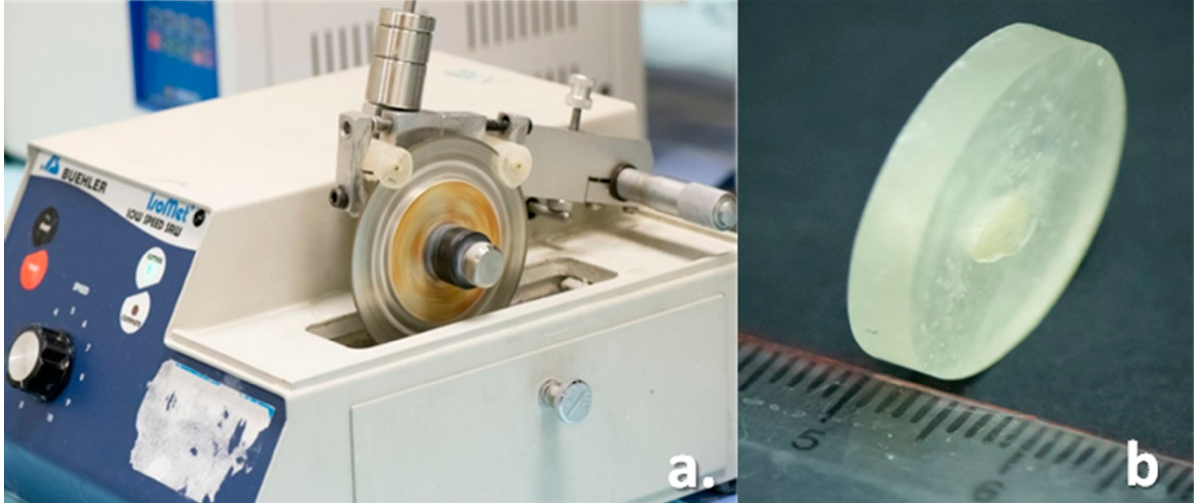
Figure 4. ( a ): Mounted specimen on Isomet precision machine for sectioning; ( b ): 4 mm slice of spec- imens obtained for push-out